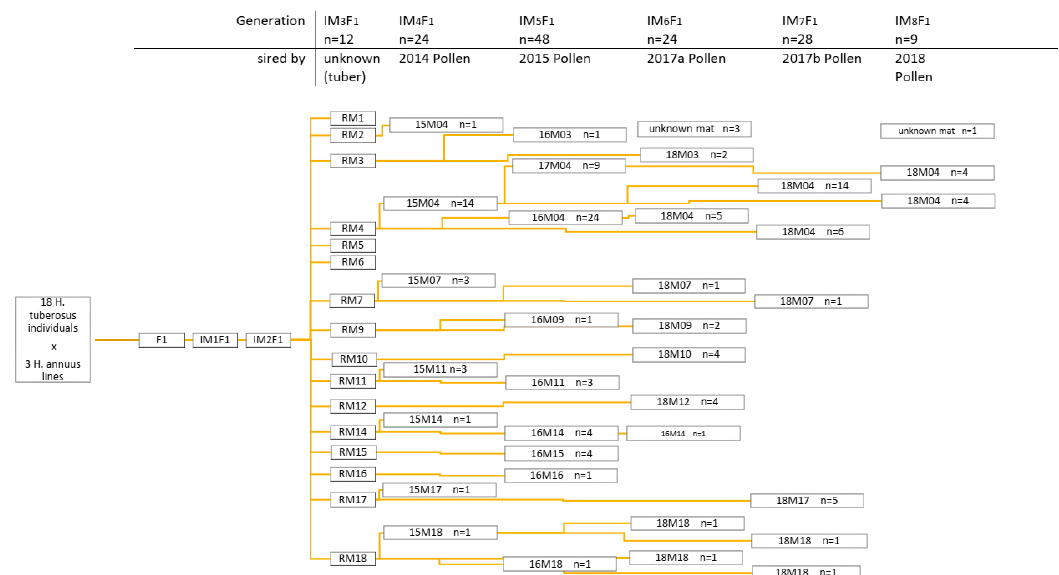
Figure 1. Pedigree of maternal lines continued in the intermated (IM) generations. Parents and F 1 populations were previously phenotyped for perenniality and domestication syndrome traits including seed size, branching, pollen fertility, head diameter, and number of heads [31]. Initial populations were selected based on a domestication syndrome trait index developed to move the population toward the perennial sunflower ideotype [30]. For the first three generations this index was used to select the top twenty percent of the maternal half sib families for inclusion in the next generation of plant material.